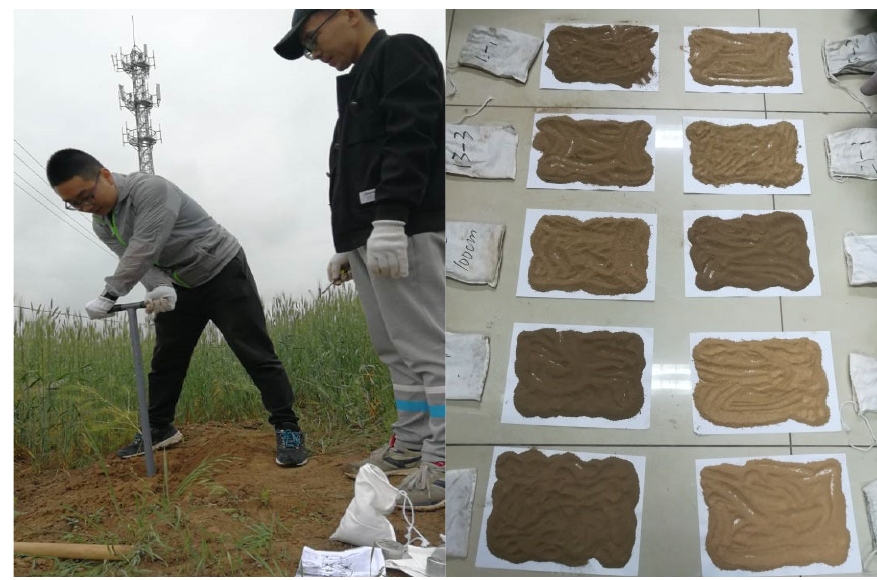
Figure 2. Field sampling and some photos of soil samples from three sampling areas. There were 49 sample points in the study area. Sampling points G18, L5 and F26 correspond to and represented 18 gully consolidation landfill sample points, 5 highland